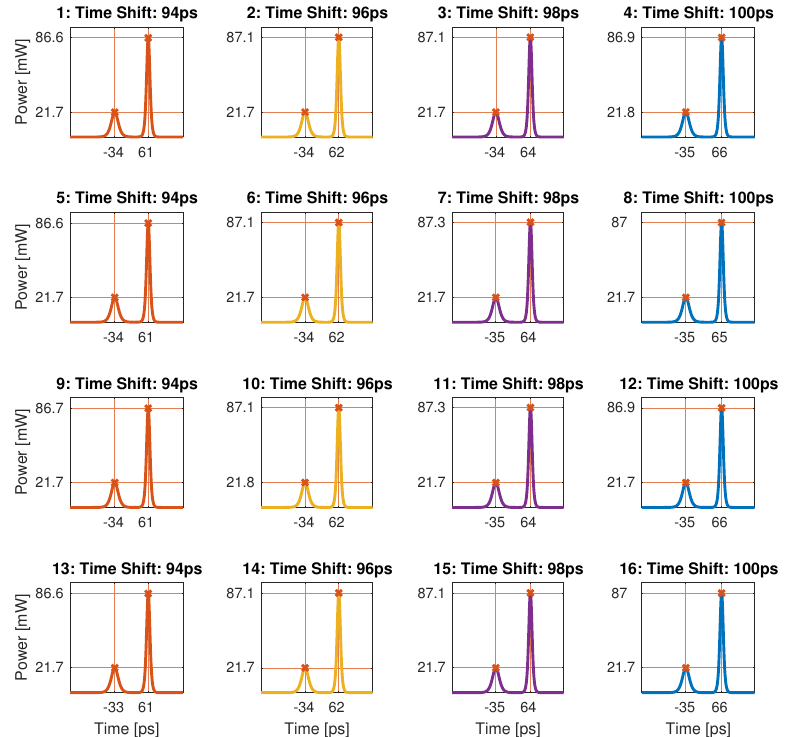
Figure A2. Waveform of all 16 possible symbols at the receiver when the phase shift is not compen- sated. There are four different patterns for each initial phase that is encoded in the two eigenvalues. The peak value of the waveforms are shown on the vertical axes in milliwatts, and the corresponding center time of the waveforms relative to the group is shown on the horizontal axes in